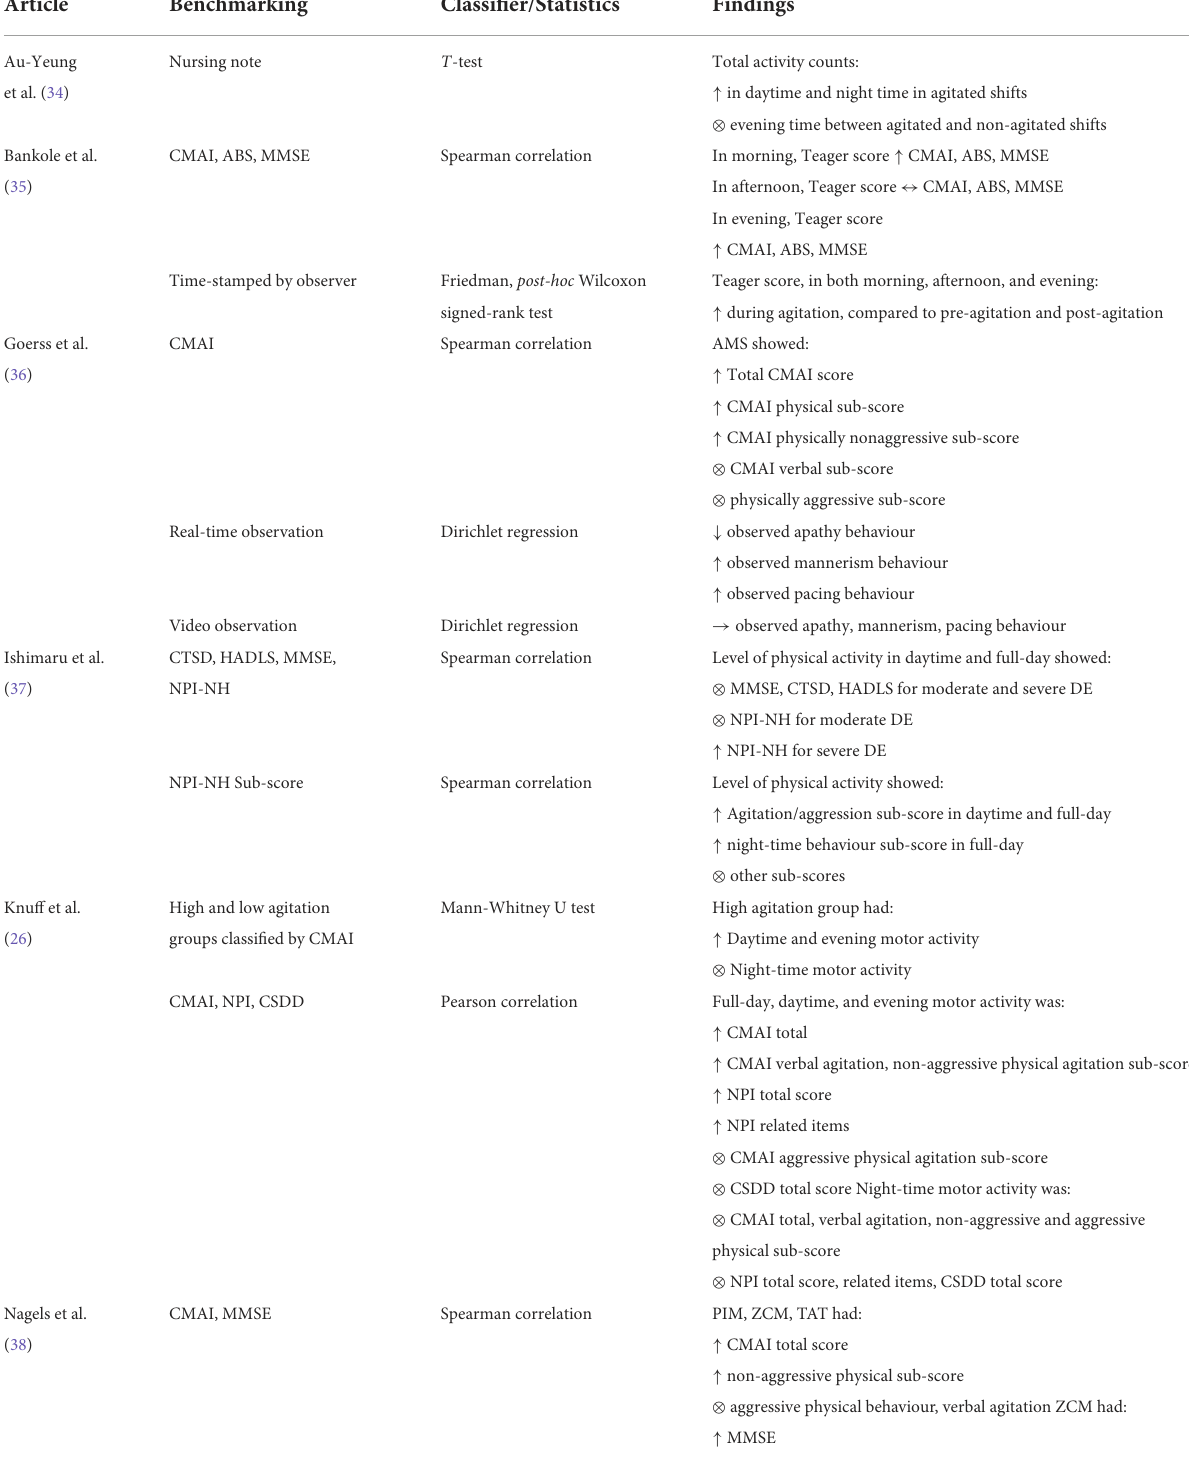
TABLE 3 Data analysis and key